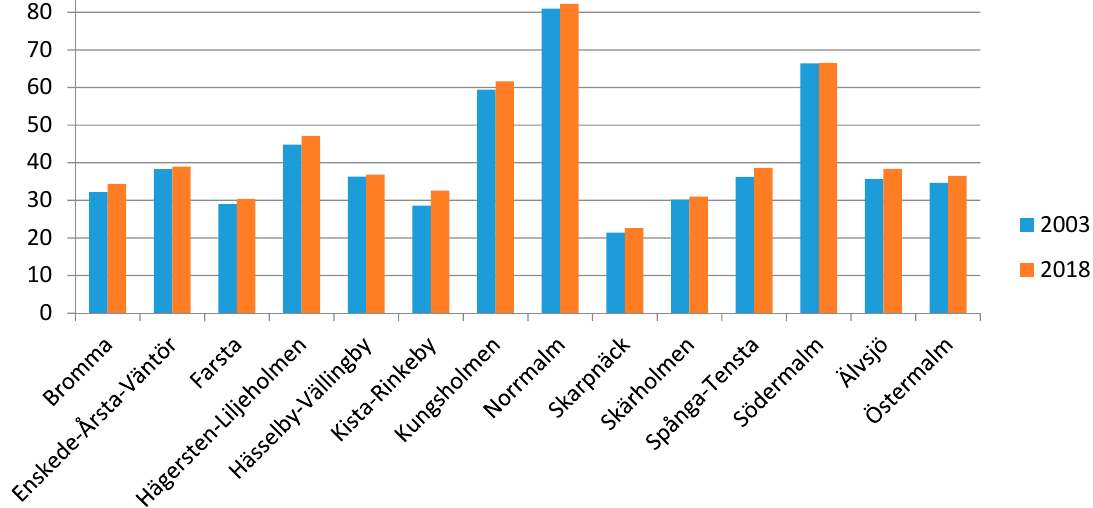
Figure 4. Change in urban land area percentage per district in Stockholm City between 2003 and 2018.